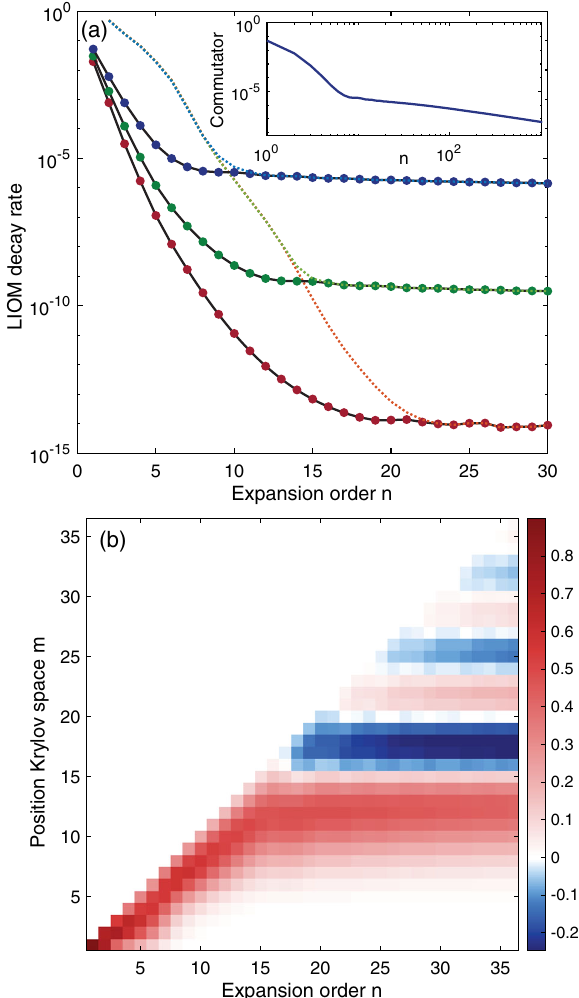
FIG. 2. Variational LIOM decay. (a) Residual decay rate of the n th-order variational Birkhoff approximation of the integral of motion associated with the impurity spin. The full circles show the best variational approximation composed out of all operators to order n . The dotted lines show the results obtained when the operators are constrained to all but the lowest eigenvalue eigenmodes of S . They become nearly degenerate at the cross- over. Different colors show different values of the impurity potential; i.e., blue, green, and red correspond to V ¼ 3 , 4, 5, respectively. The inset shows V ¼ 2 up to the order of n ¼ 1000 . (b) Ground state wave function on the Krylov space for V ¼ 4 [green curve in (a)], showing a drastic change in behavior at the